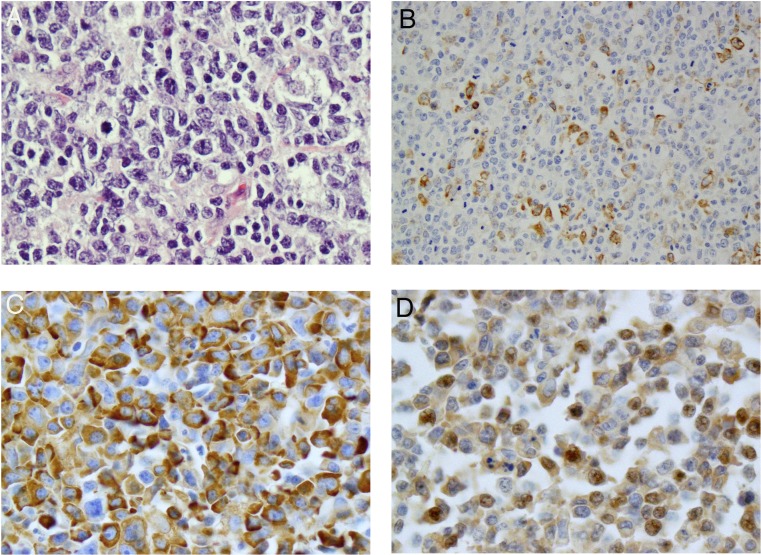
Morphologic and immunohistochemical features of AR-DLBCL.A: A representative of the AR-DLBCL cases show centroblast morphology (H&E, original magnification 400X); B: A representative case of AR-DLBCL with approximately 10% of the lymphomatous cells positive for p70S6K 240/244 (original magnification 200X); C: A representative case of AR-DLBCL with approximately 90% of the lymphomatous cells with strong immunoreactivity for p70S6K 240/244 (original magnification 400X); D: A representative case of AR-DLBCL with the majority of the lymphomatous cells showing moderate nuclear immunoreactivity for pPTEN (original magnification 400X).